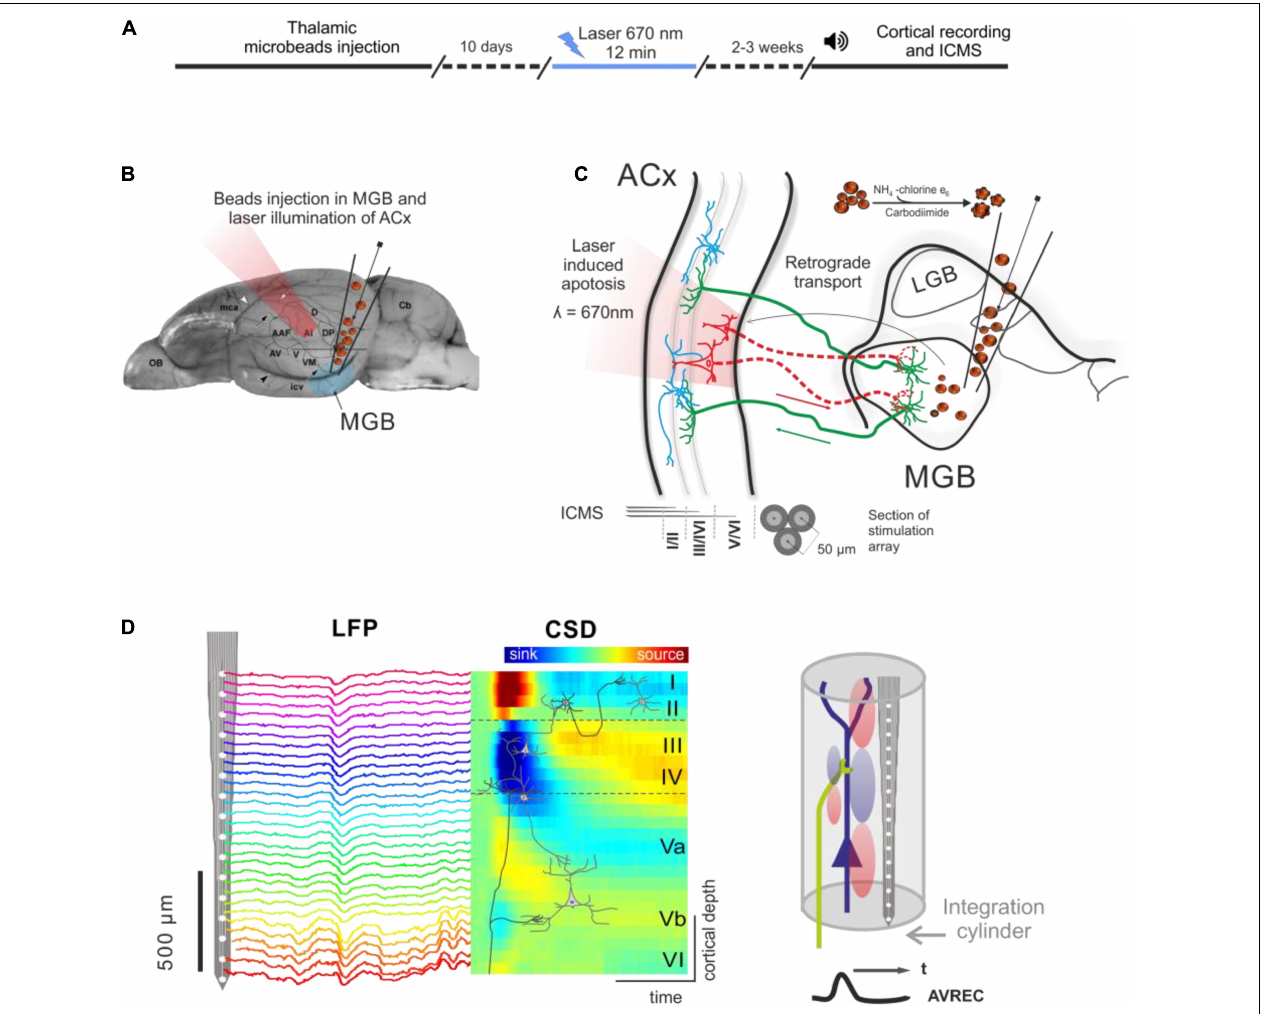
FIGURE 1 | Experimental design and photolytic apoptosis technique. (A) Timeline of the experiments from thalamic microbeads injection, laser illumination of ACx (10 days later), and cortical recordings (2–3 weeks later). (B) Unilateral injection of conjugated red retrobeads with chlorin e6 into the MGB is followed by transcranial illumination of the ACx 10 days later. (C) Retrograde transport to the CT projection neurons and laser illumination induces a photolytic apoptosis of CT feedback by the release of reactive oxygen species. Electrodes used for intracortical microstimulation (ICMS) were placed in supragranular, granular and infragranular layers of the auditory cortex. (D) Laminar recordings of the local field potential (LFP) across all cortical layers in the ACx are transformed into the current source density (CSD) distribution in order to map the spatiotemporal profile of synaptic transmission. Current sinks are thereby interpreted as locations of excitatory synaptic input ( right ). Roman numbers indicate cortical layers, as in all following figures. Dashed lines indicate boundaries between supragranular, granular and infragranular